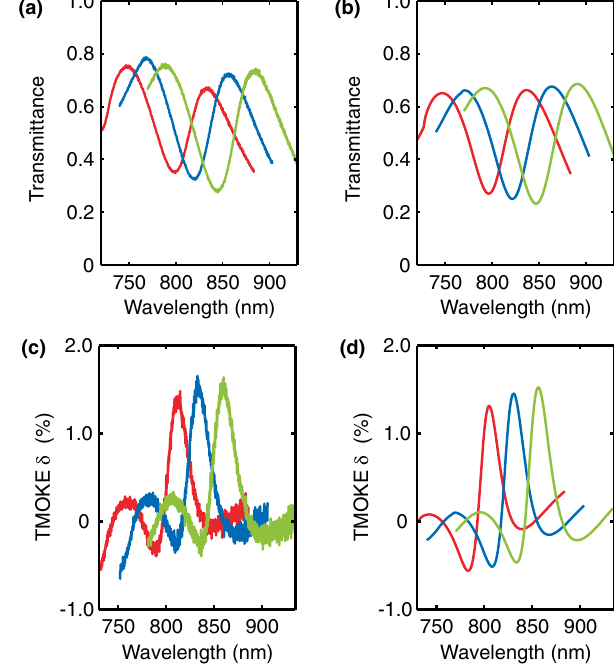
FIG. 2. (a) Measured spectra of the TMOKE signal (cid:1) at differ- ent static magnetic fields of 1.6 mT, 6.4 mT, 16 mT, 48 mT, and 160 mT, respectively. (b) Measured maximum TMOKE signal (cid:1) max increasing with the external magnetic field. The incident angle is 9 (cid:2) . (c) Measured (cid:1) at different incident angles at a magnetic field of 160 mT. From the bottom to the top, the incident angles are (cid:1) 9 (cid:2) , (cid:1) 7 (cid:2) , (cid:1) 5 (cid:2) , (cid:1) 3 (cid:2) , (cid:1) 1 (cid:2) , 0 (cid:2) , þ 1 (cid:2) , þ 3 (cid:2) , þ 5 (cid:2) , þ 7 (cid:2) , þ 9 (cid:2) , and þ 11 (cid:2) , respectively. The spectra in (a) and (c) are shifted vertically for better visibility.